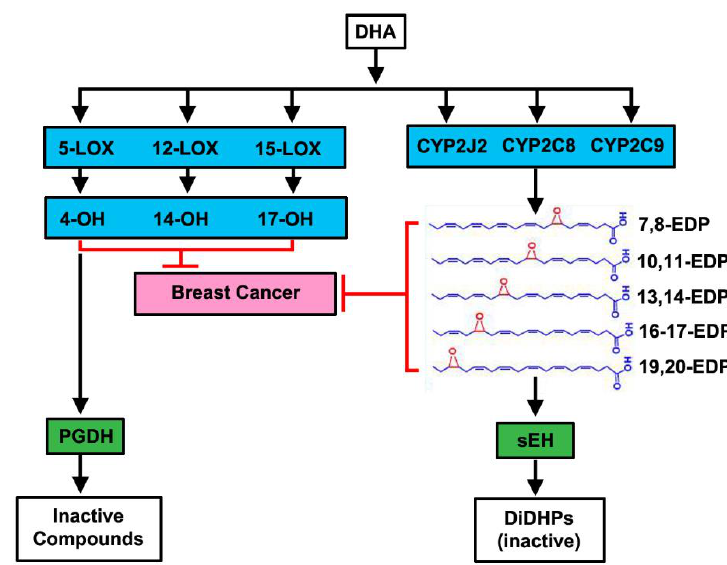
Figure 10. Schematic of the metabolism of DHA.